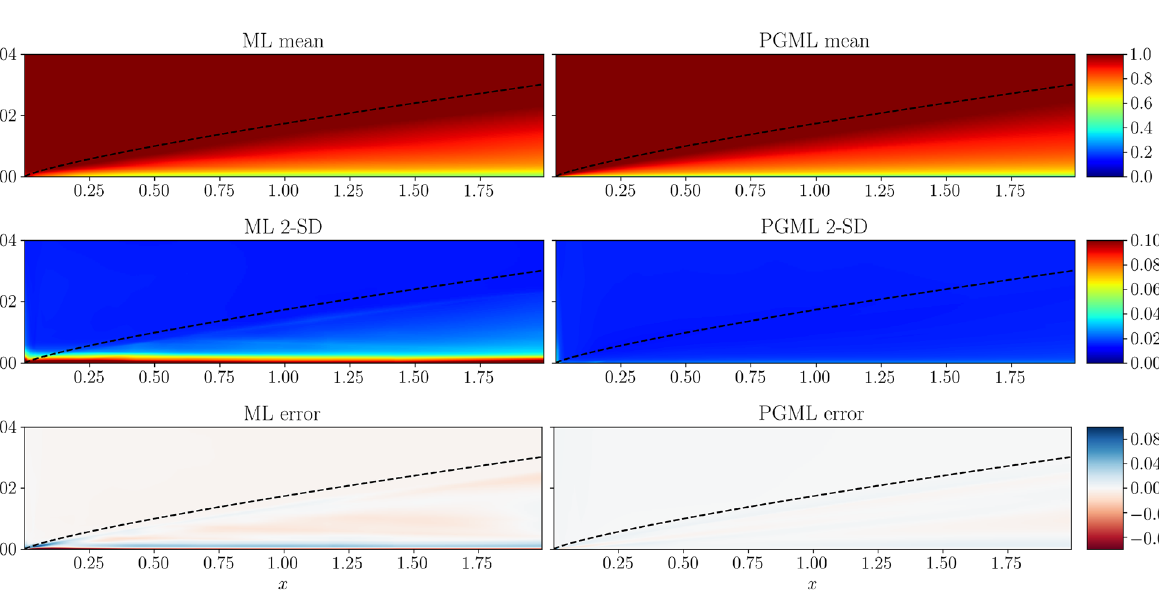
Figure 8. Prediction of the turbulent flat plate boundary layer with 30% of data used for training the ML and PGML model. The error is calculated as the difference between the true flow field and the flow field predicted by ML and PGML models. The figure is created by Matplotlib v3.5.1 50